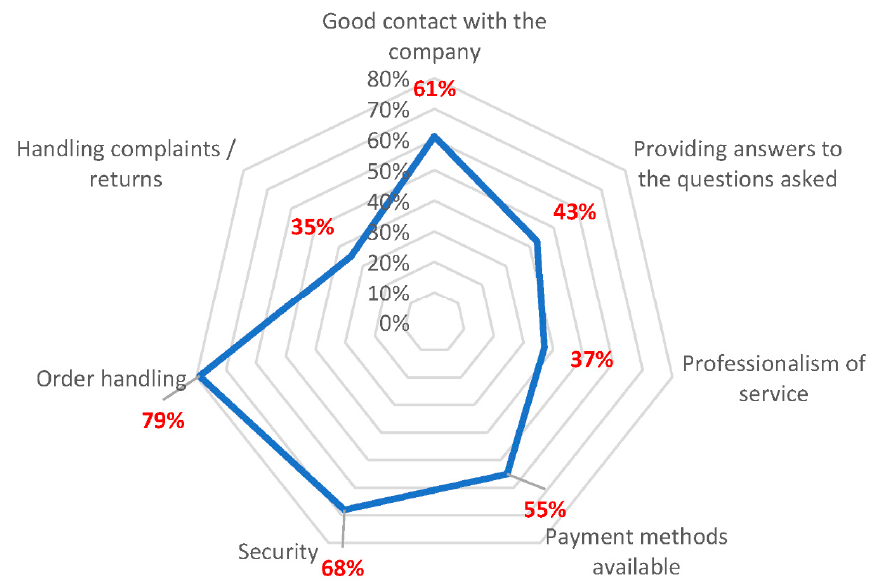
Figure 4. Factors influencing customer value.